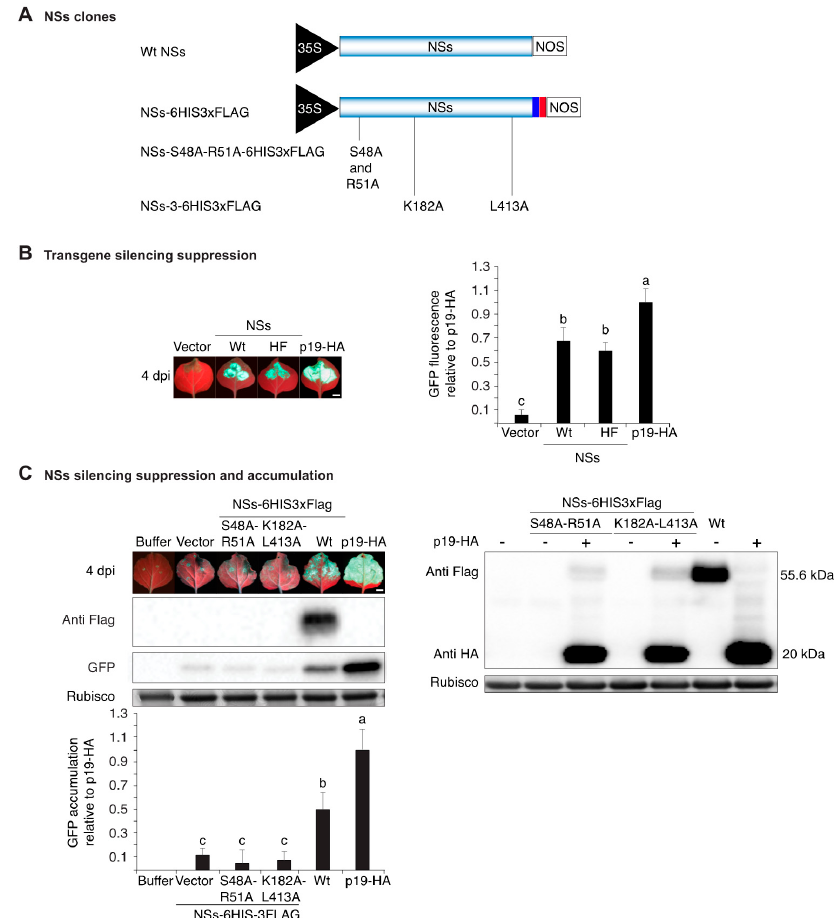
Figure 1. GFP transgene silencing suppression and NSs protein accumulation. ( A ) Representation of TSWV NSs clones placed between the 35S promoter and the nopaline synthase (NOS) terminator in pMDC32. A 6HIS-3xFLAG (referred to as HF) tag added in frame at the C terminus is indicated by colored boxes. Inactivating mutations in RNA binding domain one (S48A and R51A), in the GKT motif and in the YL motif are indicated; ( B ) Suppression of transgene silencing by wt and HF-tagged